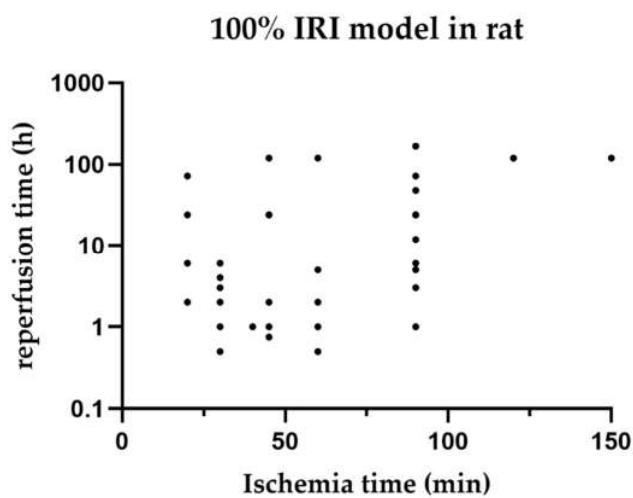
Figure 3. Distribution of reperfusion time compared with their ischaemia times in 100% ischaemia models in rats. Studies with various reperfusion times are listed for each individual time point. Time points are listed regardless of the survival time of animals.